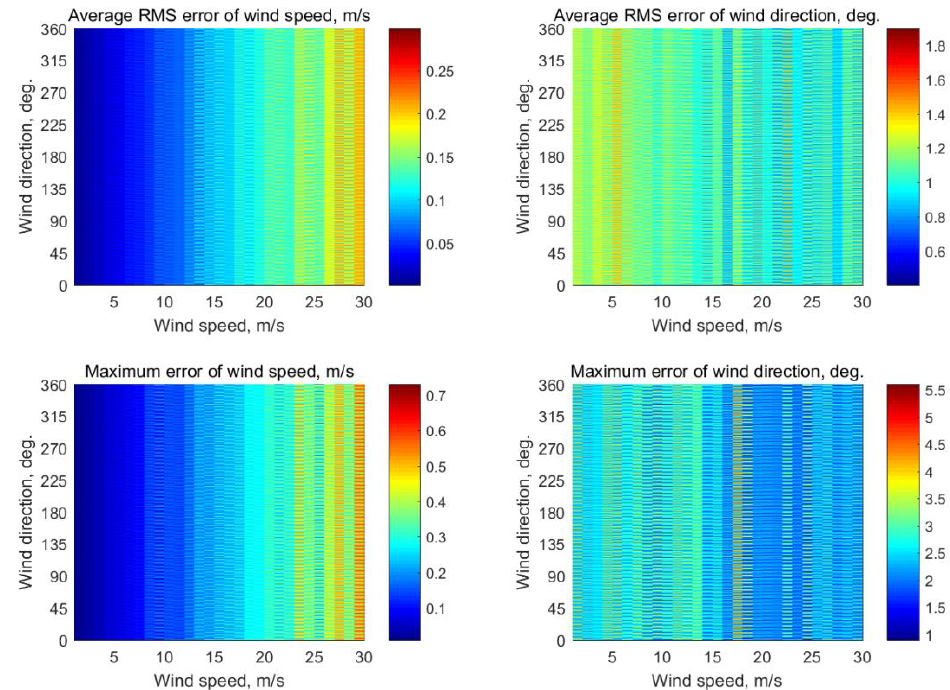
Figure A4. Simulation results of the use of only one incidence angle of 45° for wind retrieval.